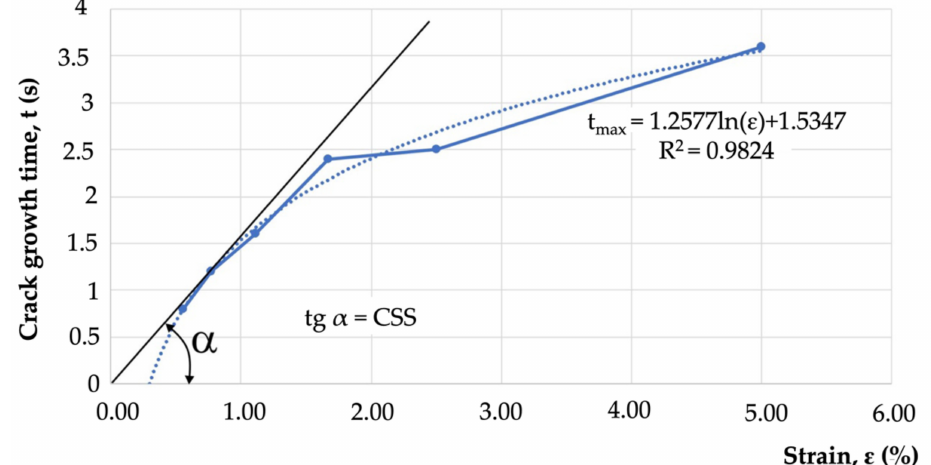
Figure 15. Hot-crack growth time as a function of specimen deformation in the transvarestraint test.The CSS value for the case in question was 1.71 1/s, which indicated that the alloy was highly susceptible to hot cracking during remelting. The results obtained enabled the determination of exponential ductility curves using ε = f(T) (Figure